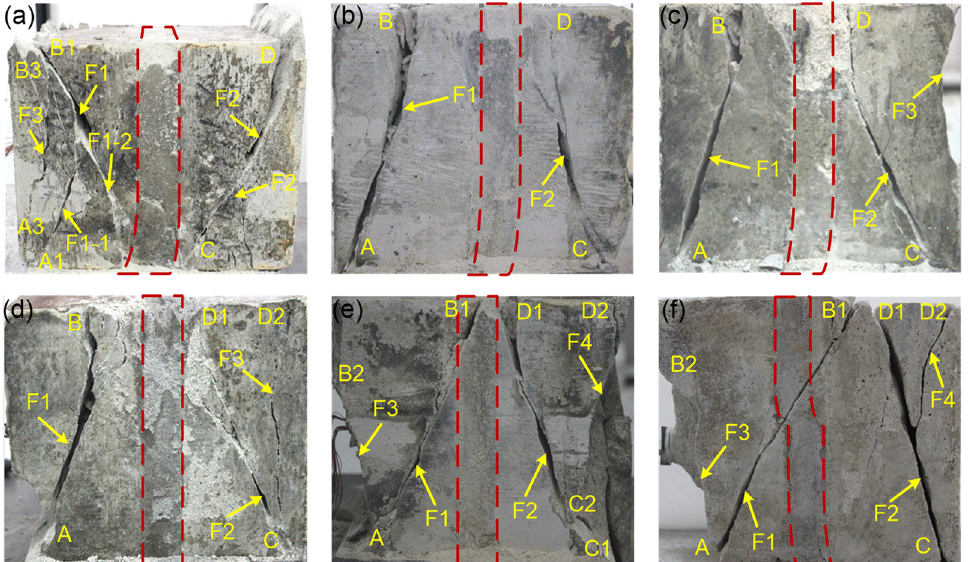
Figure 12. Failure characteristics of samples containing weak interlayer with different uniaxial compressive strength: ( a ) σ w = 0.22 MPa; ( b ) σ w = 0.46 MPa; ( c ) σ w = 0.80 MPa; ( d ) σ w = 1.27 MPa; ( e ) σ w =1.74 MPa; ( f ) σ w = 2.02 MPa.